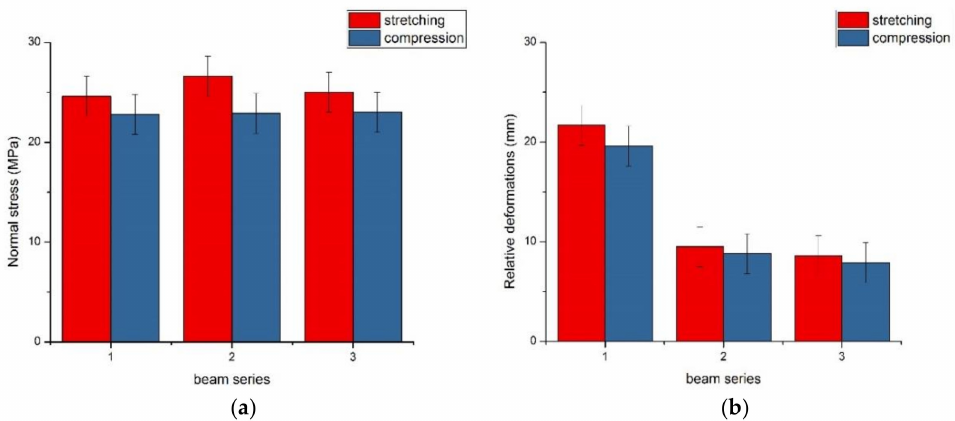
Figure 8. Maximum normal stresses ( a ) and relative deformations ( b ) in the wood beams of various types: 1—solid wood beam; 2—composite beam with a reinforcement coefficient of 0.016; 3—composite beam with a reinforcement coefficient of